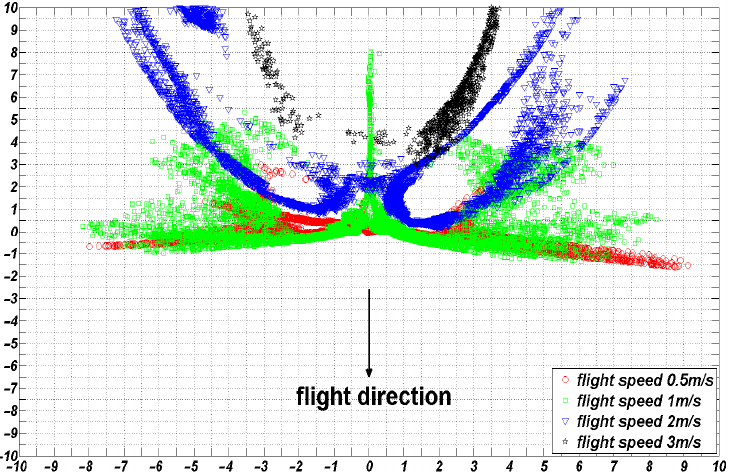
Figure 14. Droplet deposition situation at a flight height of 3 m, crosswind speed of 0 m/s, and different flight speeds.